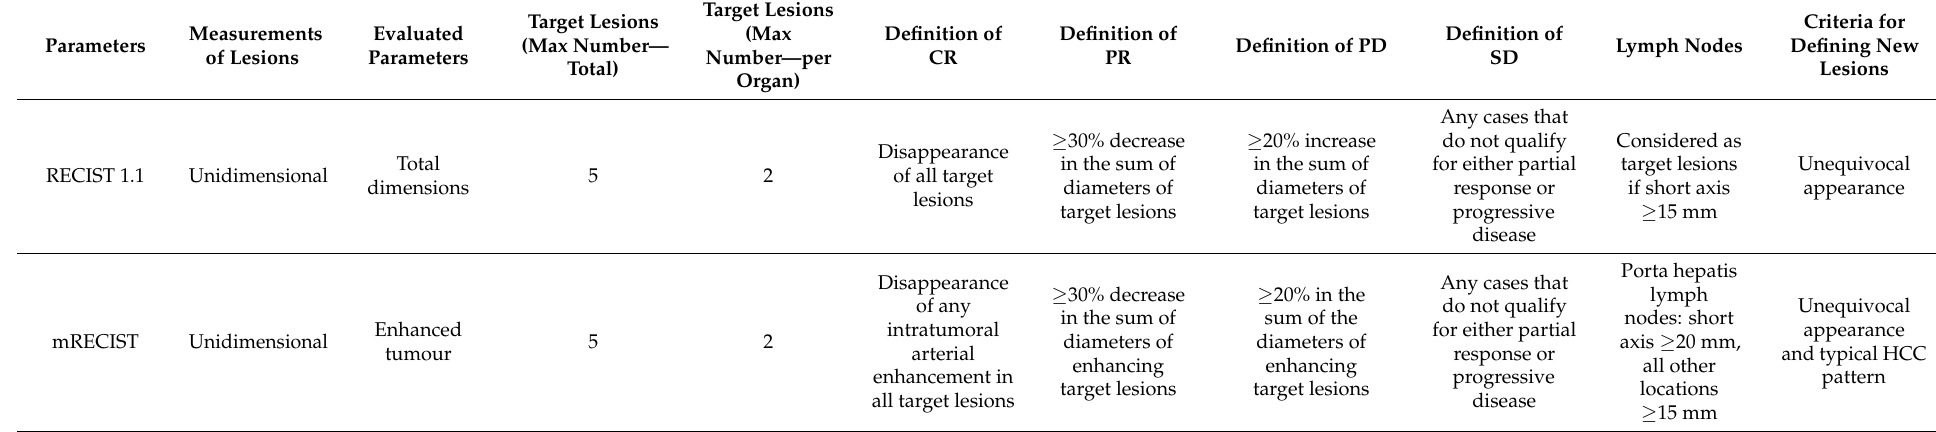
Table 2. Radiological criteria to assess responses to systemic treatments for HCC according to RECIST 1.1, mRECIST, and